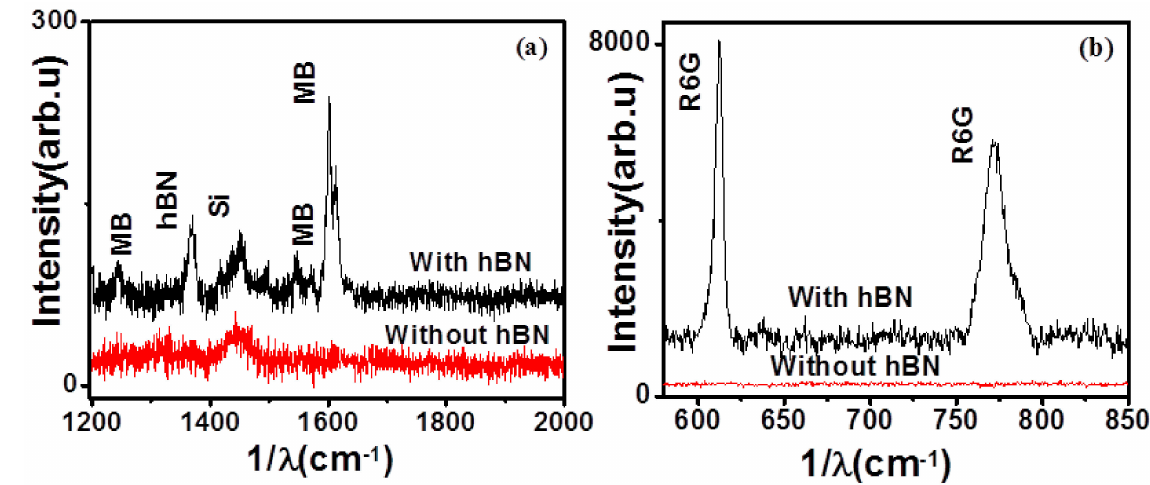
Figure 3. Enhancement of the Raman signal of ( a ) 1 µ M methylene blue (MB) and ( b ) 50 µ M Rhodamine 6G (R6G) over 6 nm hBN. The Raman spectra with hBN and without hBN are shown.